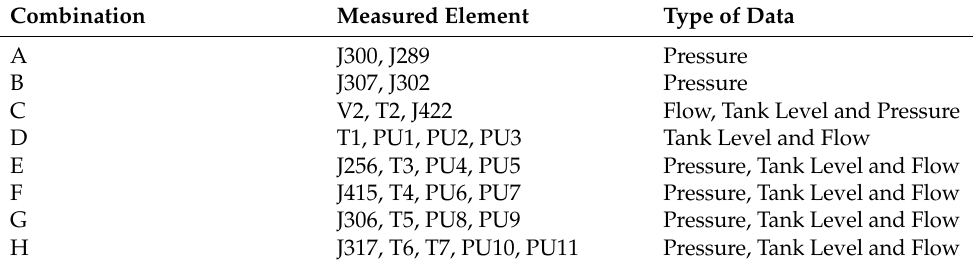
Table 1. Description of control and measuring devices for fastICA